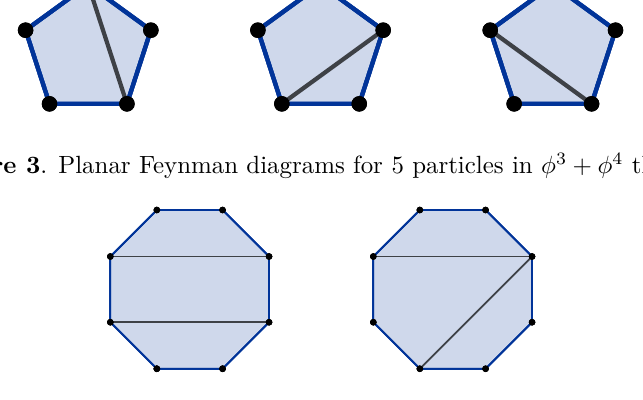
Figure 4 . Inequivalent diagrams for 8 -particle scattering in φ 4